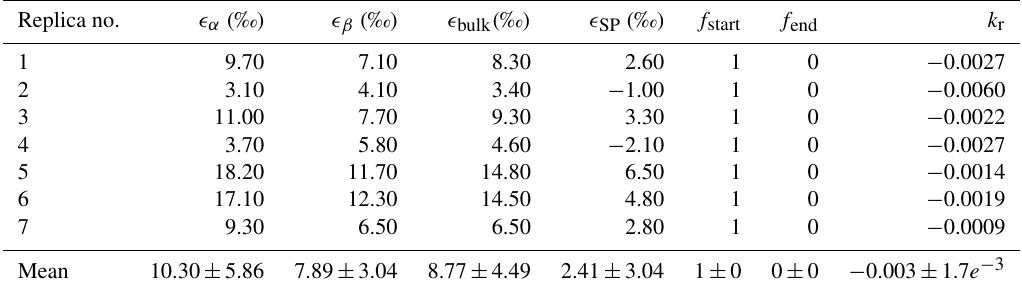
Table 3. Isotopic fractionation, extremes of the unreacted fraction parameter ( f start and f end ), and reduction rate ( k r ) in k p in ppm(minmL KNO 3 ) − 1 for the reduction of N 2 O from P. fluorescens . Replica no.